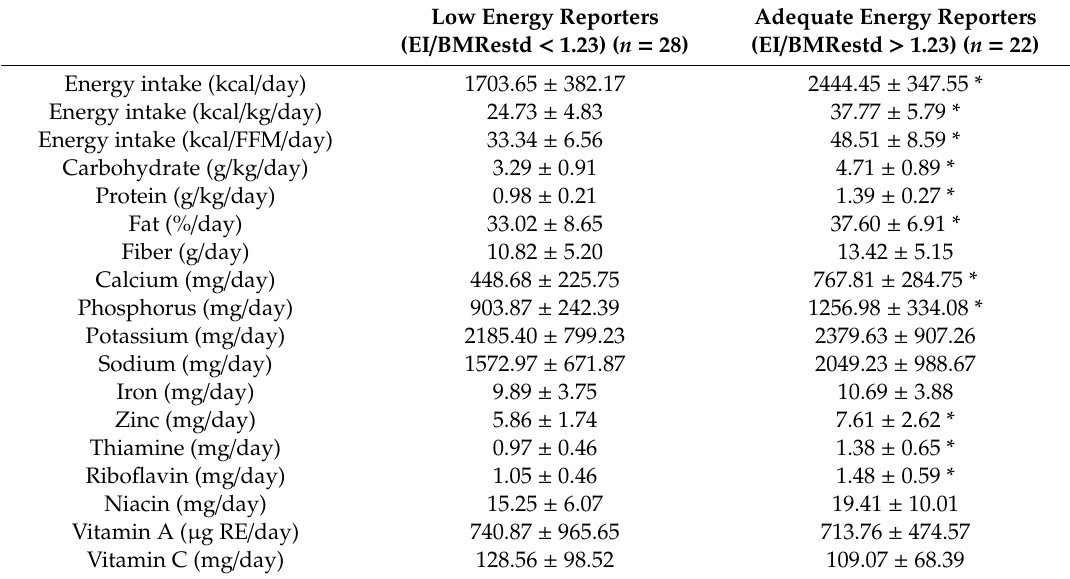
Table 3. Mean daily nutrient intake of athletes classified as low and adequate energy reporters based on the ratio of energy intake to the estimated basal metabolic rate (Mean ±